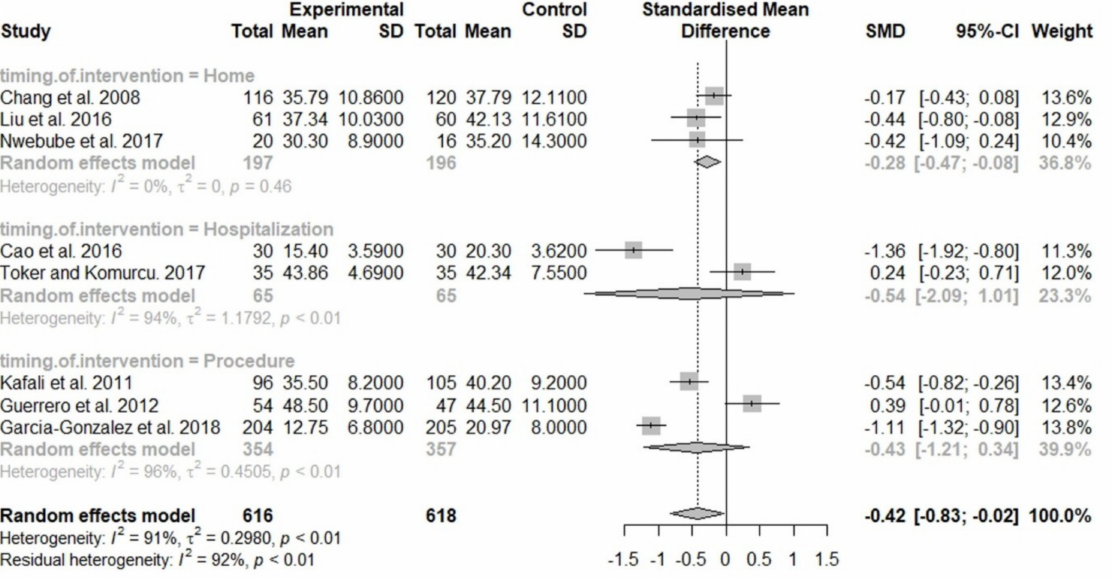
Figure 3. Forest plot of pooled anxiety scores after the intervention, comparing the music group and the control group (Subgroup analysis by the timing of interventions). SD, standard deviation; SMD, standardized mean di ff erence; CI, confidence interval.